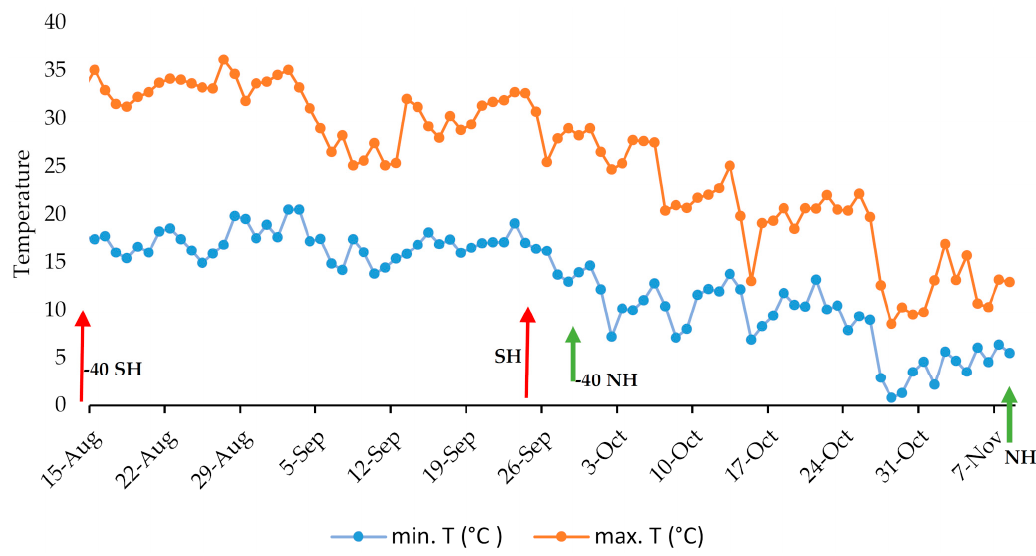
Figure 2. Maximum and minimum temperatures between 40 days before harvest date ( − 40SH red, − 40NH green) and the harvesting dates on September 25th (SH red) and November 8th (NH green) of 2018.